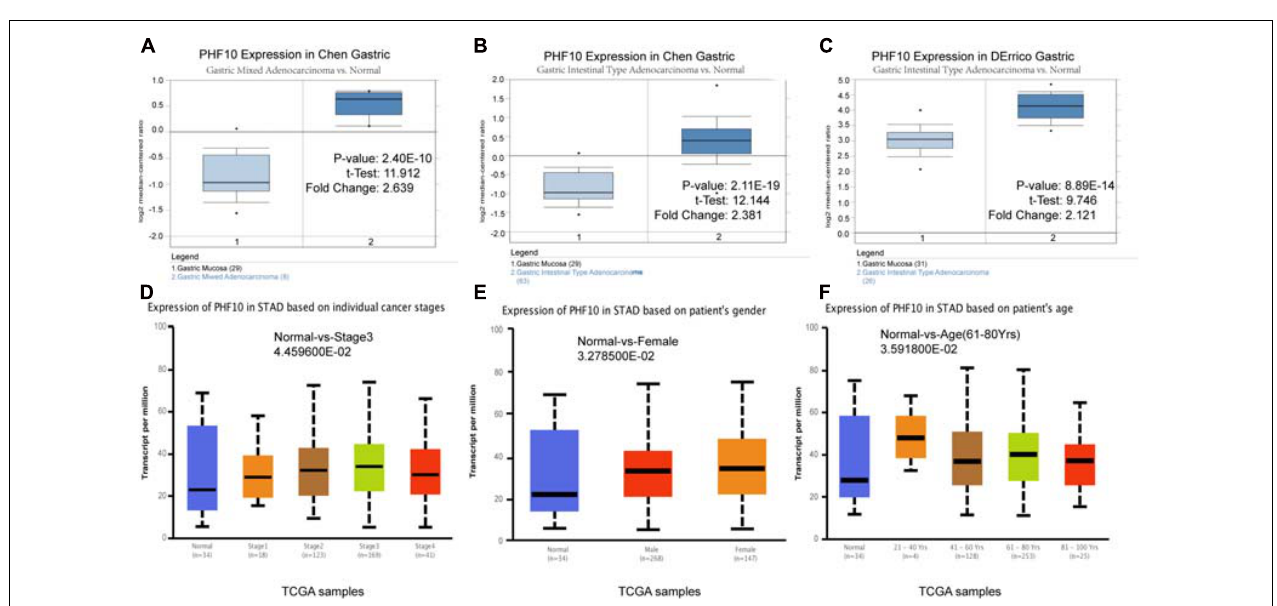
FIGURE 6 | Expression of PHF10 between samples with different subtypes and normal samples from three studies using ONCOMINE database (A–C) . Expression of PHF10 in TCGA STAD based on clinicopathological parameters visualized by the UALCAN web server. The analysis was done to predict the expression of STAD and their relative tissue based on, (D) stages, (E) gender, and (F)